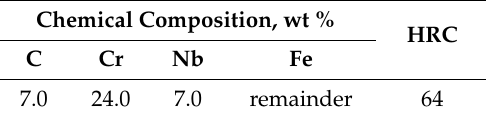
Table 5. Chemical composition of the layer formed by GMA (Gas Metal Active) with a ceramo-metallic wire